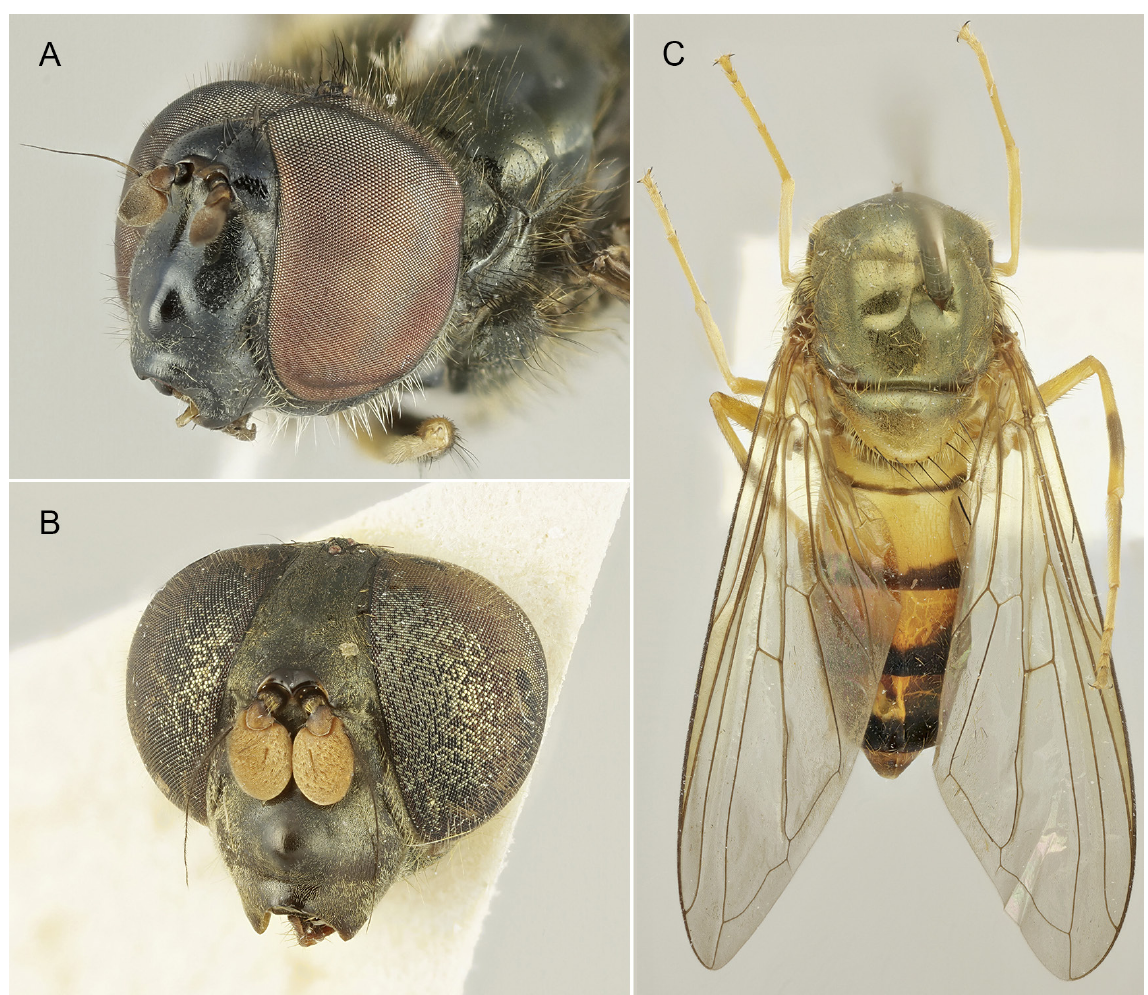
Fig. 14. A . Cheilosia ( Cheilosia ) difficilis Hervé-Bazin, 1929, ♂ (CNC); head. – B–C . Cheilosia ( Rubrocheila ) egregia Barkalov & Cheng, 1998, ♂ (CSCA); head and body, dorsal views. Not to